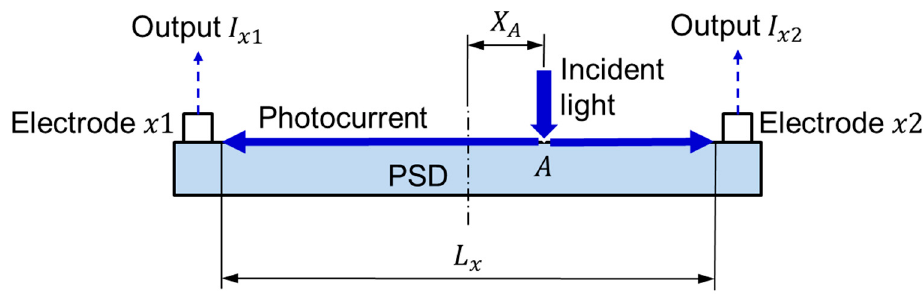
Figure 3. Position sensing principle of 1D − PSD.